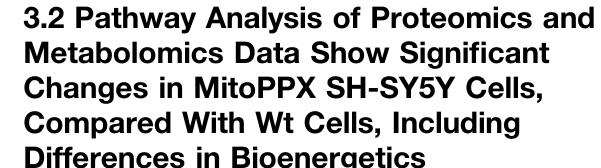
Frontiers in Cell and Developmental Biology |